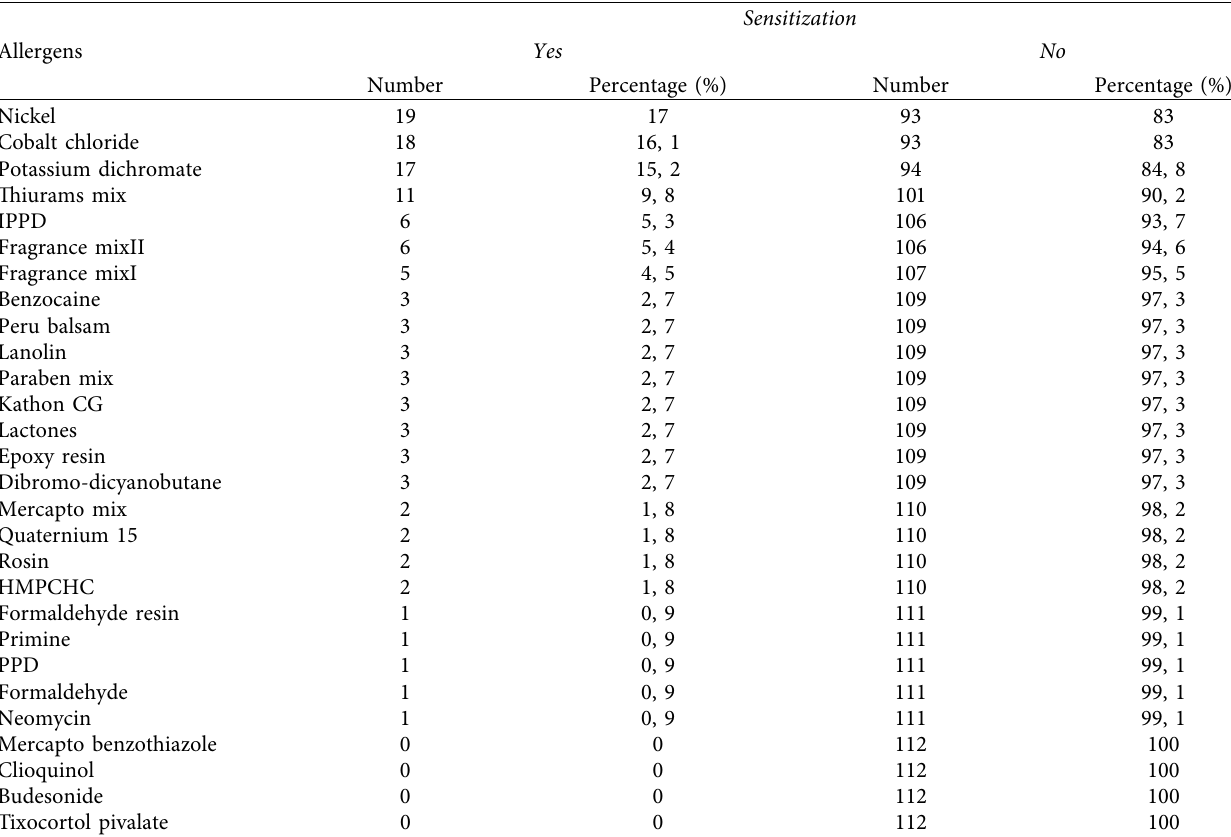
Table 2: Results of EBS allergen patch